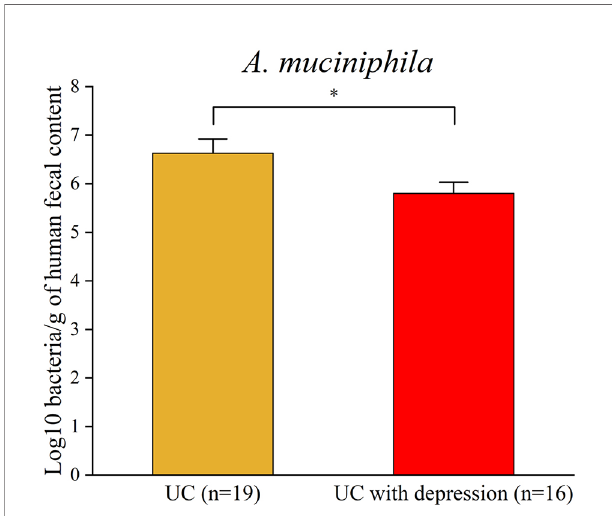
FIGURE 4 | Real-time PCR analysis validated the reduction in A. muciniphila in UC patients with depression. *p <